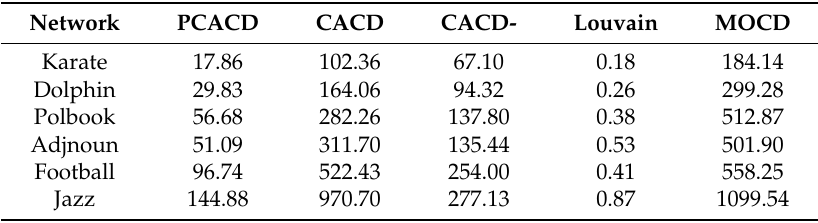
Table 2. The CPU time (s) spent by each algorithm for six real-world networks (PCACD: parallel conical area community detection algorithm; CACD: conical area community detection algorithm; CACD-: conical area community detection algorithm variant without the local search strategy; MOCD: multi-objective community detection